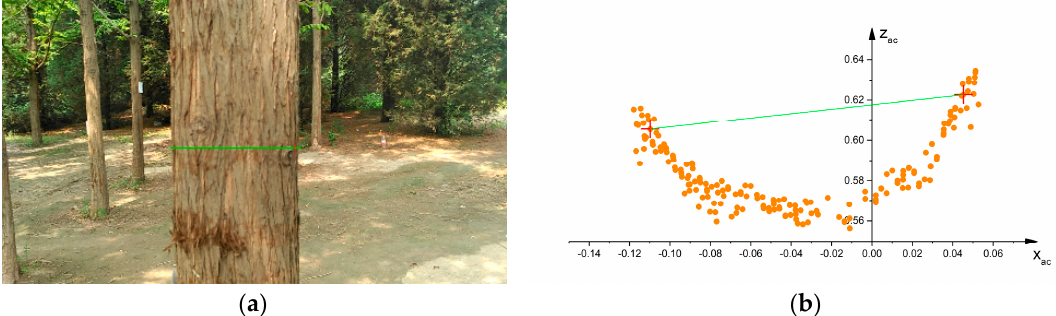
Figure 11. The stem boundary detection result by a uniform distribution: ( a ) the boundaries in the RGB image; ( b ) the boundaries on the plane O ac − x ac − z ac . The two edges of the stem were underestimated due to the assumption of uniform distribution.